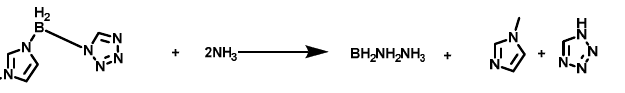
Figure 9. Isodesmic reaction of the (1-methylimidazolium)(tetrazol-1-yl)borane.